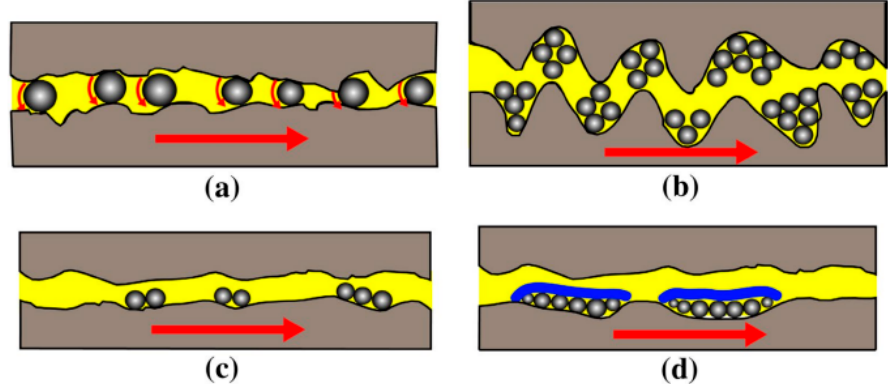
Figure 7. Schematic illustration of the ( a ) rolling mechanism; ( b ) self-repair, or mending mechanism; ( c ) polishing mechanism; and ( d ) tribo-film formation. Reprinted with permission from Ref. [33]. 2019, Springer.